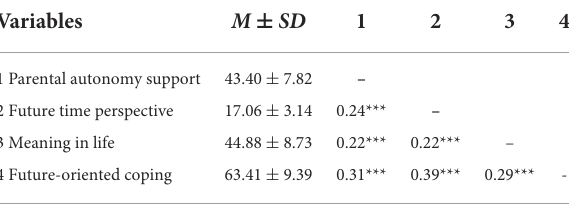
TABLE 1 Means, SDs, and correlations between